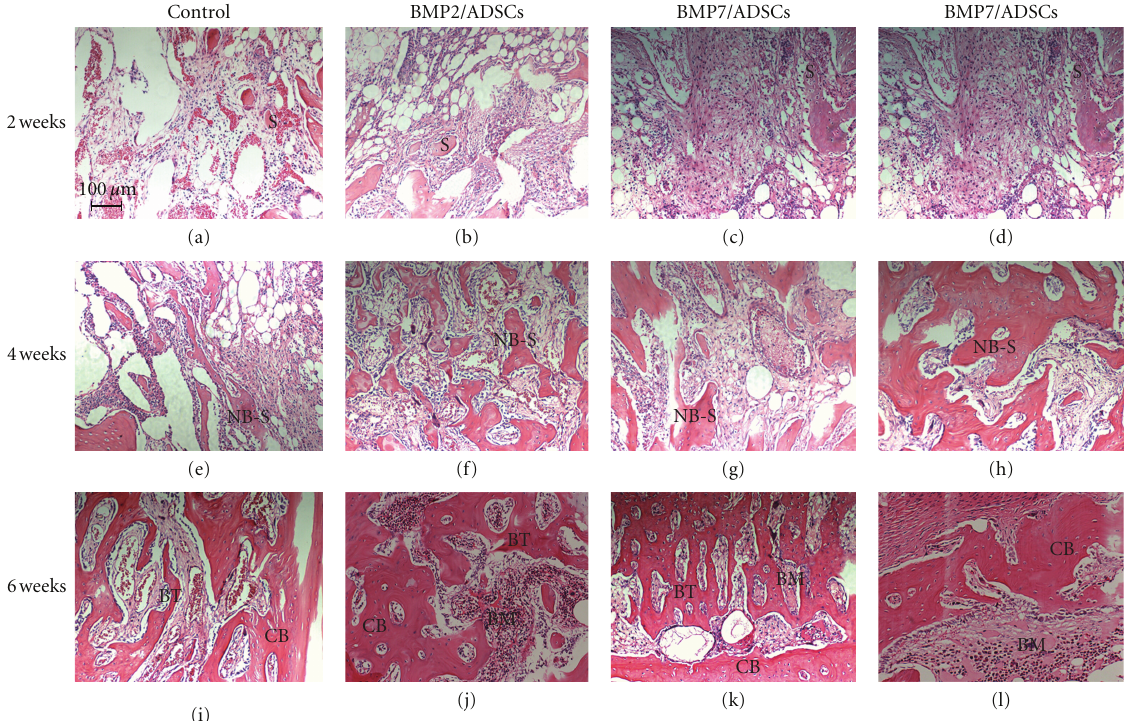
Figure 6: HE staining of the transverse bone defect sections in di ff erent groups at 2 weeks, 4 weeks, and 6 weeks post-surgery. Abbreviations used: sca ff old (S); new bone from implanted sca ff old (NB-S); bone marrow (BM), cortical bone (CB), bone trabecular (BT). Bar = 100 μ m.